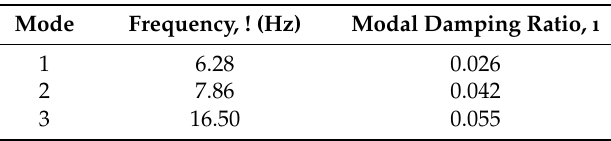
Table 6. Modal damping ratios obtained by experiments.